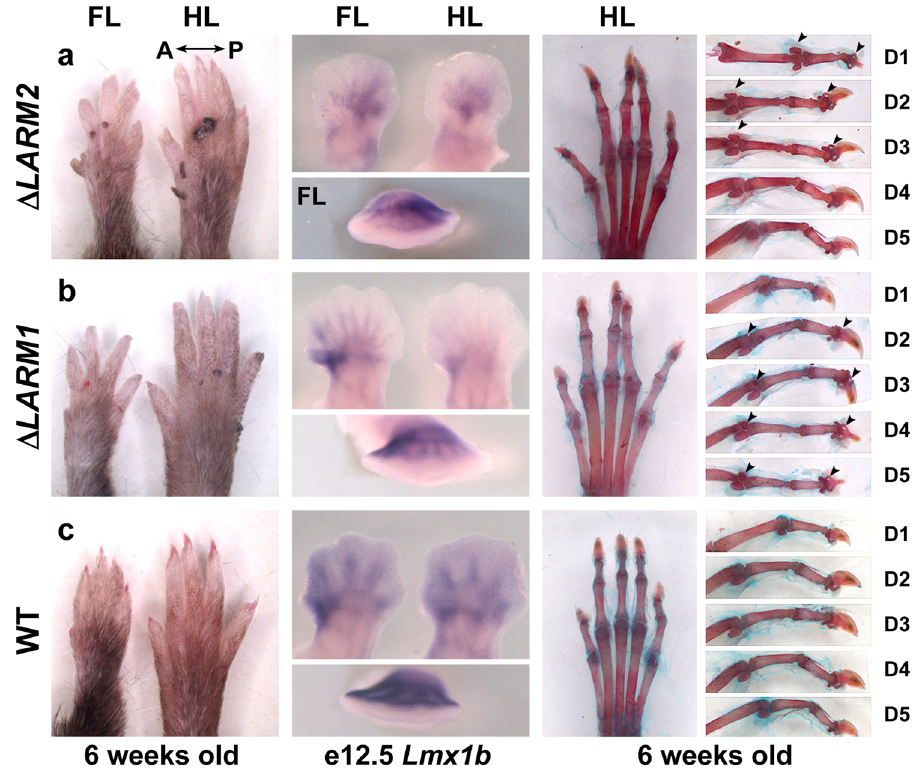
Fig. 6 Individual deletions of LARM 1 and LARM 2 reveal posterior and anterior contributions, respectively, to dorsalization. a Homozygous Δ LARM2 mouse forelimb (FL) and hindlimb (HL) autopods showing loss of dosalization exclusively in the anterior aspect at 6 weeks (left), reduced anterior expression of Lmx1b in e12.5 limb buds (middle) and ventral-ventral morphology speci fi cally in anterior 1 – 3 digits (right). b Homozygous Δ LARM1 mouse showing loss of dorsalization that is accentuated posteriorly at 6 weeks (left), reduced posterior expression of Lmx1b in e12.5 limb buds (middle) and ventral-ventral morphology speci fi cally in digits 2 – 5 (right). Note the progressive loss of dorsalization towards digit 5 (e.g., increasing size of duplicated ventral sesamoid bones). c Equivalent views of a wild-type littermate for comparison. Arrowheads highlight the duplicated ventral sesamoid bones and distal